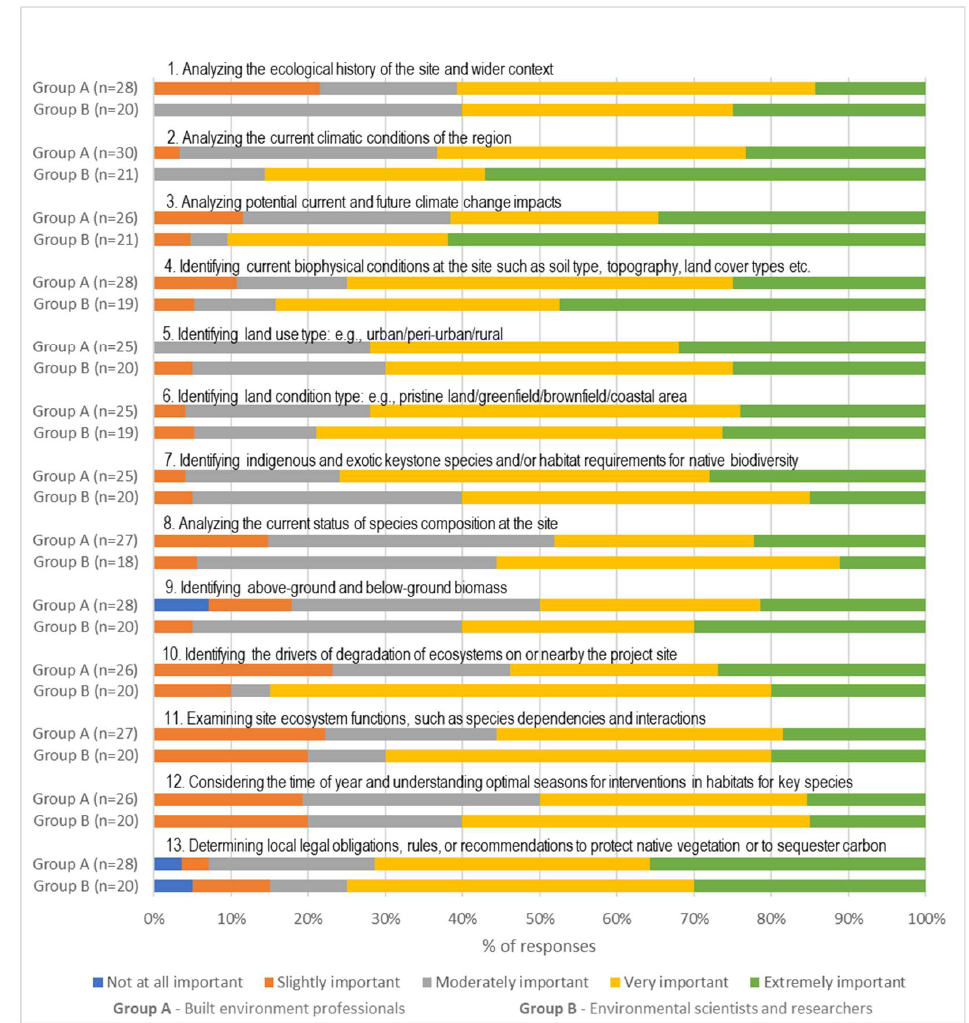
Figure 5. Research or data gathering approaches for carbon sequestration.